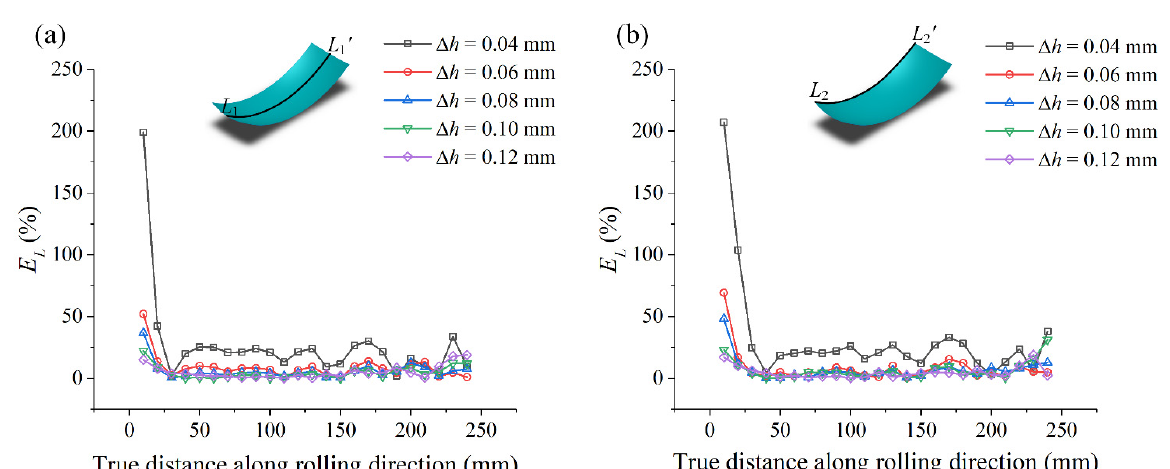
Figure 9. Longitudinal curvature radius deviation of the formed spherical surface parts in FEM: ( a ) along longitudinal line